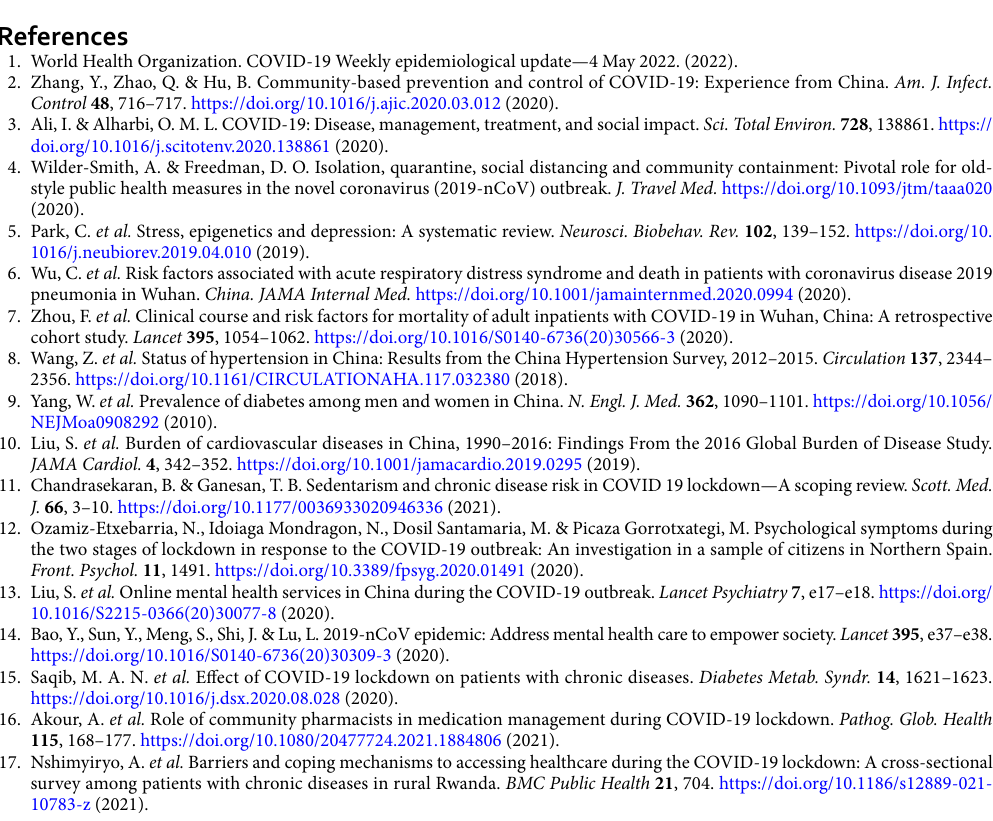
Table 2. Selected characteristics and their relation with incident depressive symptom during the COVID- 19 lockdown (n = 2820). Dashes indicate inapplicable or not included in the model. Women with depressive symptom at baseline were excluded from this analyses. *Variables were not included in the multivariable model if they were not significantly associated with incident depressive symptom in the univariable models. † Adjusting all variables listed in this